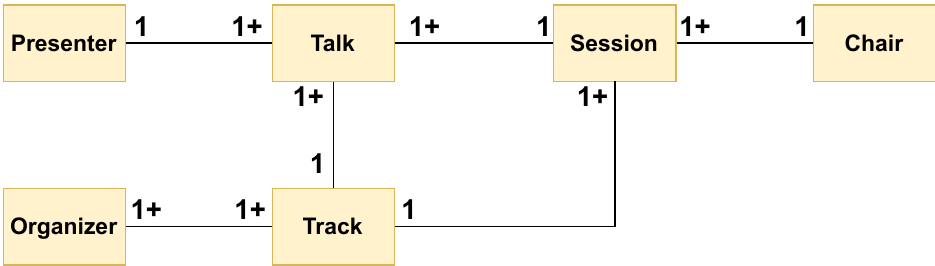
Figure 3. Entity–relationship model diagram of the elements considered in the track-based conference scheduling problem